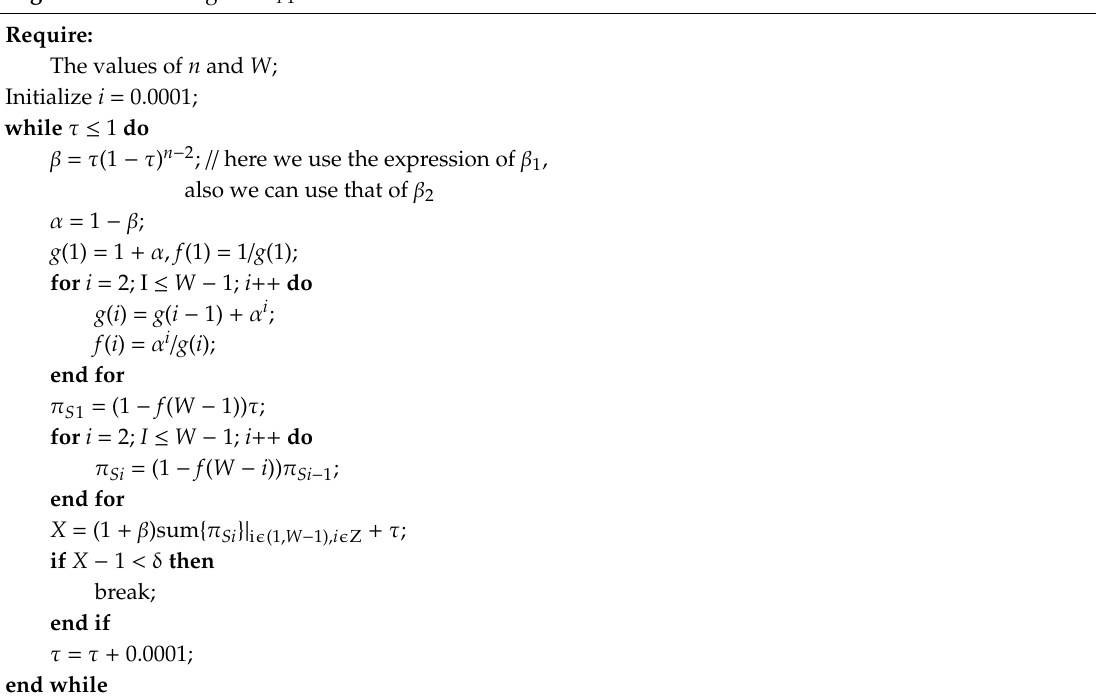
Algorithm 1. Solving the π T 1 of each